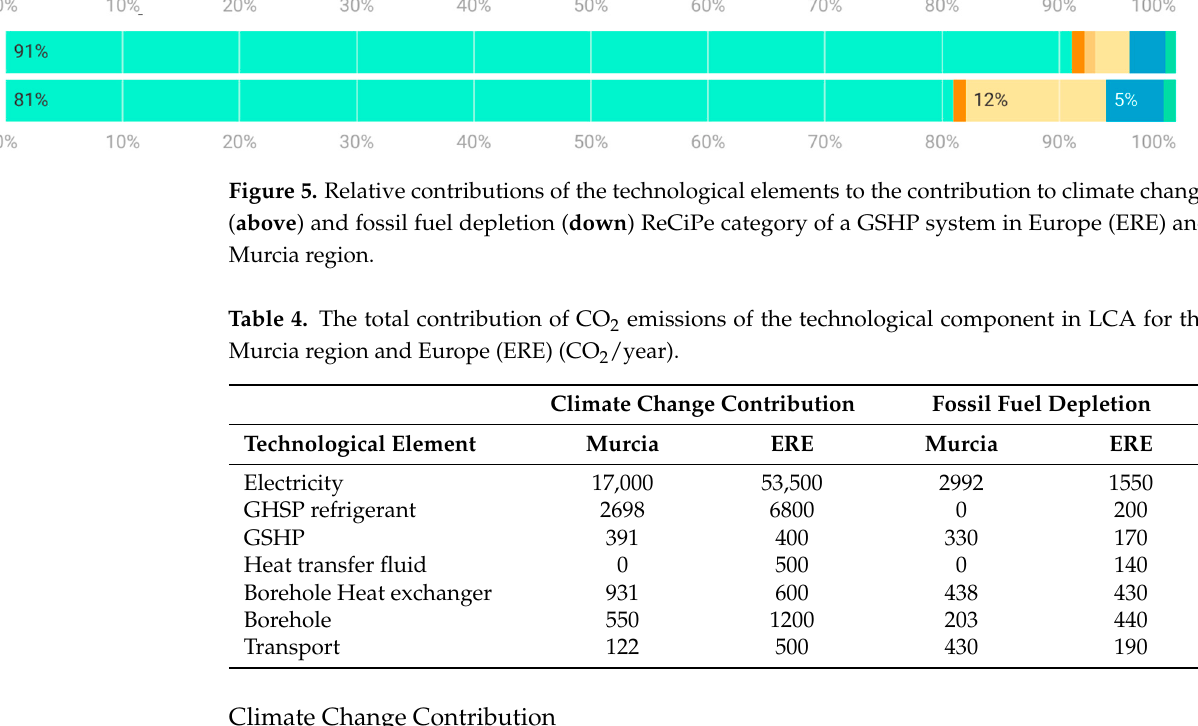
Table 4. The total contribution of CO 2 emissions of the technological component in LCA for the Murcia region and Europe (ERE). (CO 2 /year).